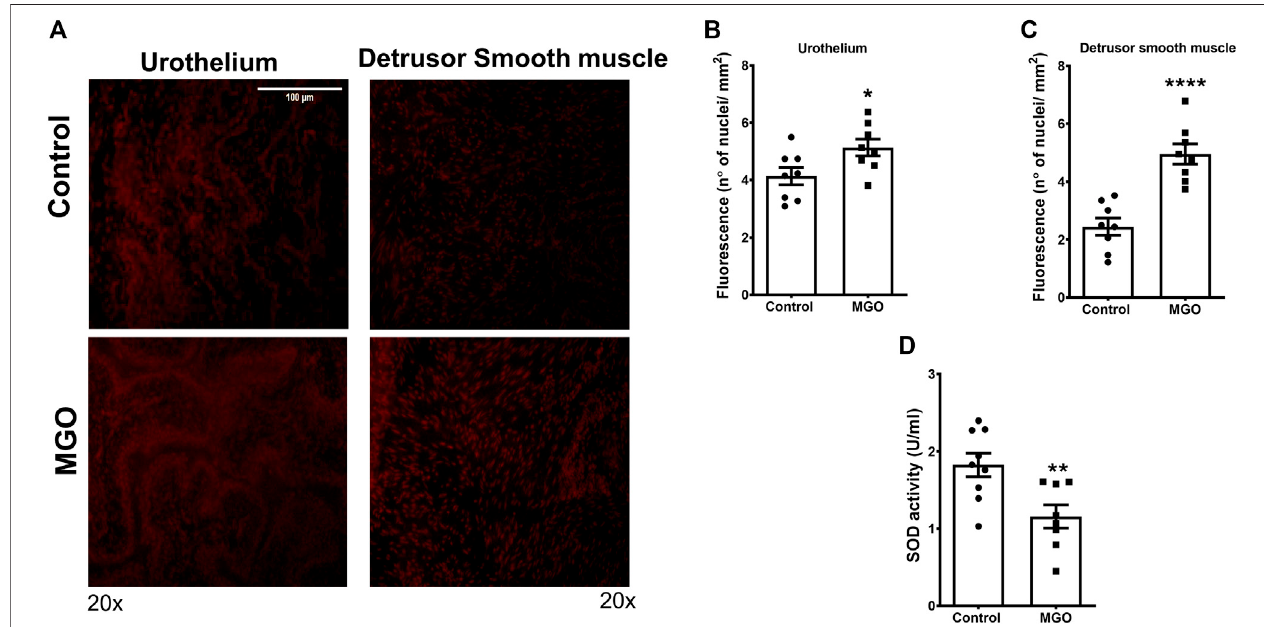
FIGURE 4 | Methylglyoxal (MGO) treatment increases the reactive-oxygen species (ROS) levels in urothelium and detrusor smooth muscle and decreases SOD activityinbladders.Panel (A) showsrepresentativeimagesofROSmeasurementthroughdyedihydroethidium-induced fl uorescenceinurotheliumanddetrusorsmooth muscle in control and MGO groups (20×). Panels (B,C) show quantitative ROS levels in urothelium and detrusor smooth muscle, respectively. Panel (D) shows superoxide dismutase (SOD) activity ( n = 8). Data are expressed as mean ± SEM. * p < 0.05, ** p < 0.01, **** p < 0.0001 compared with control group. White bar in panel A represents a scale of 100 um (×20